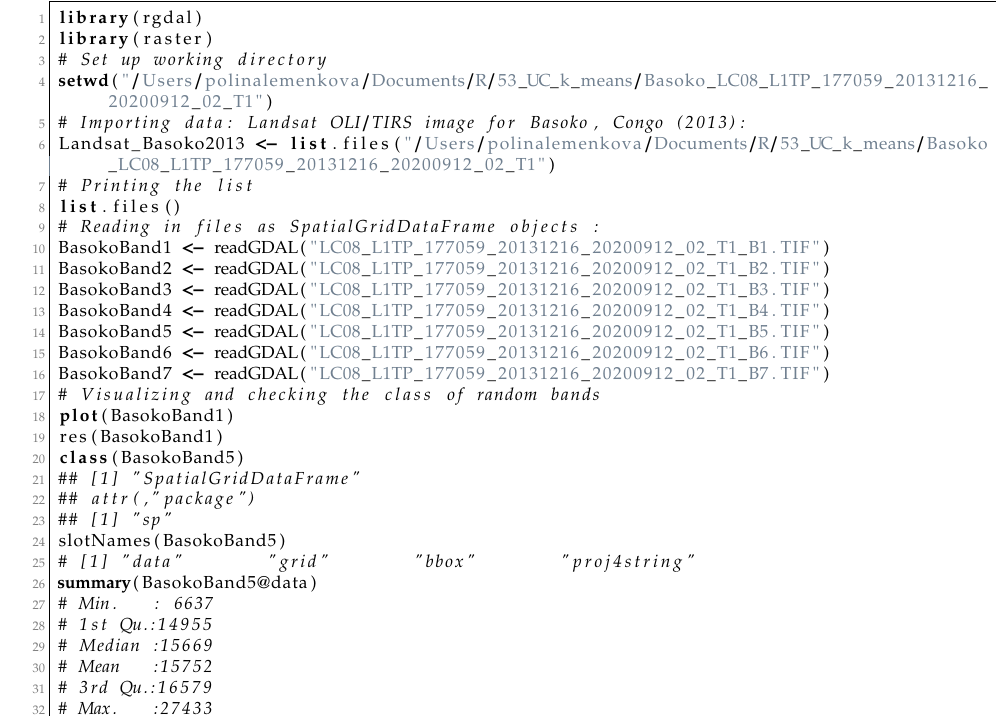
Abbreviations used in Table 2: SA—sun zzimuth. Date stands for the acquisition date of the scene; GCP Ver.—GCP version; TWRS P.—target WRS path; GCP Mod.—GCP model; GRMSEM—geometric RMSE